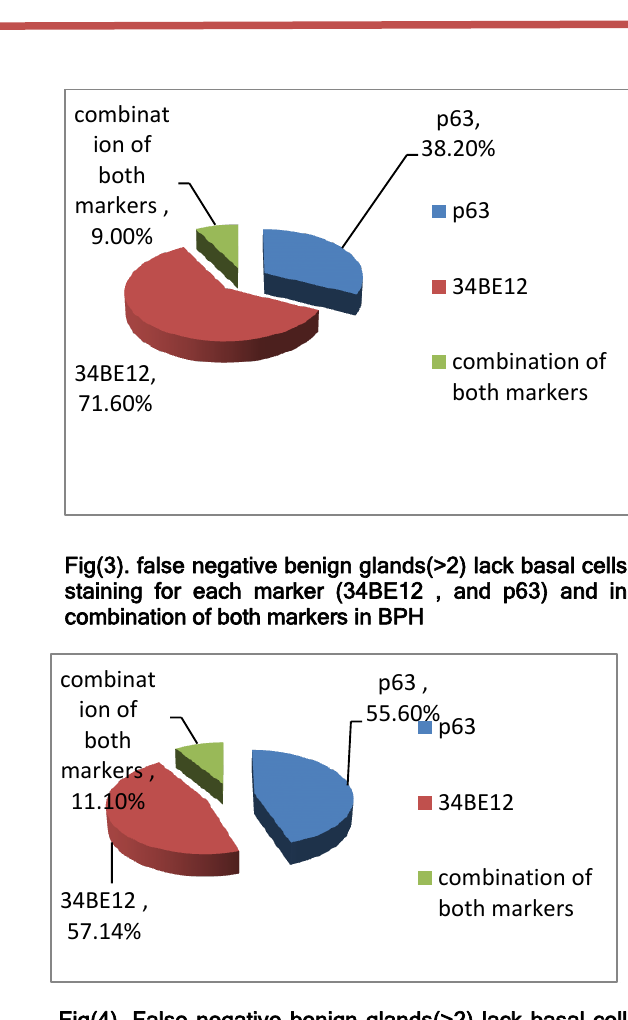
Fig(4). False negative benign glands(>2) lack basal cell staining for each marker(34BE12 , and p63 ) and in combination of both makers in HPIN